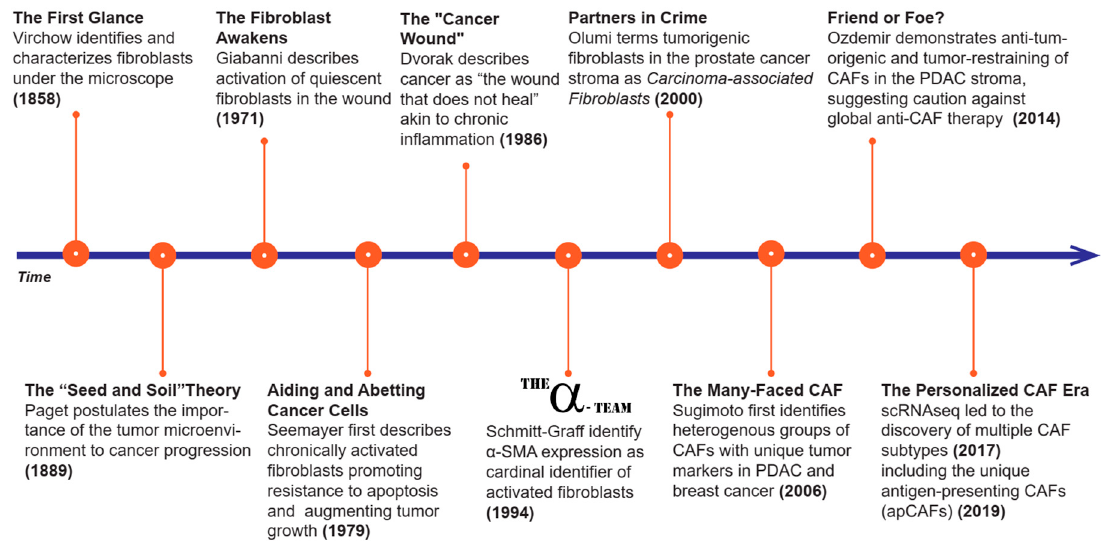
Figure 1. History of cancer associated fibroblasts (CAFs). This figure represents a timeline of CAF related discoveries. Here we highlight the major landmarks in CAF research that helped advance this